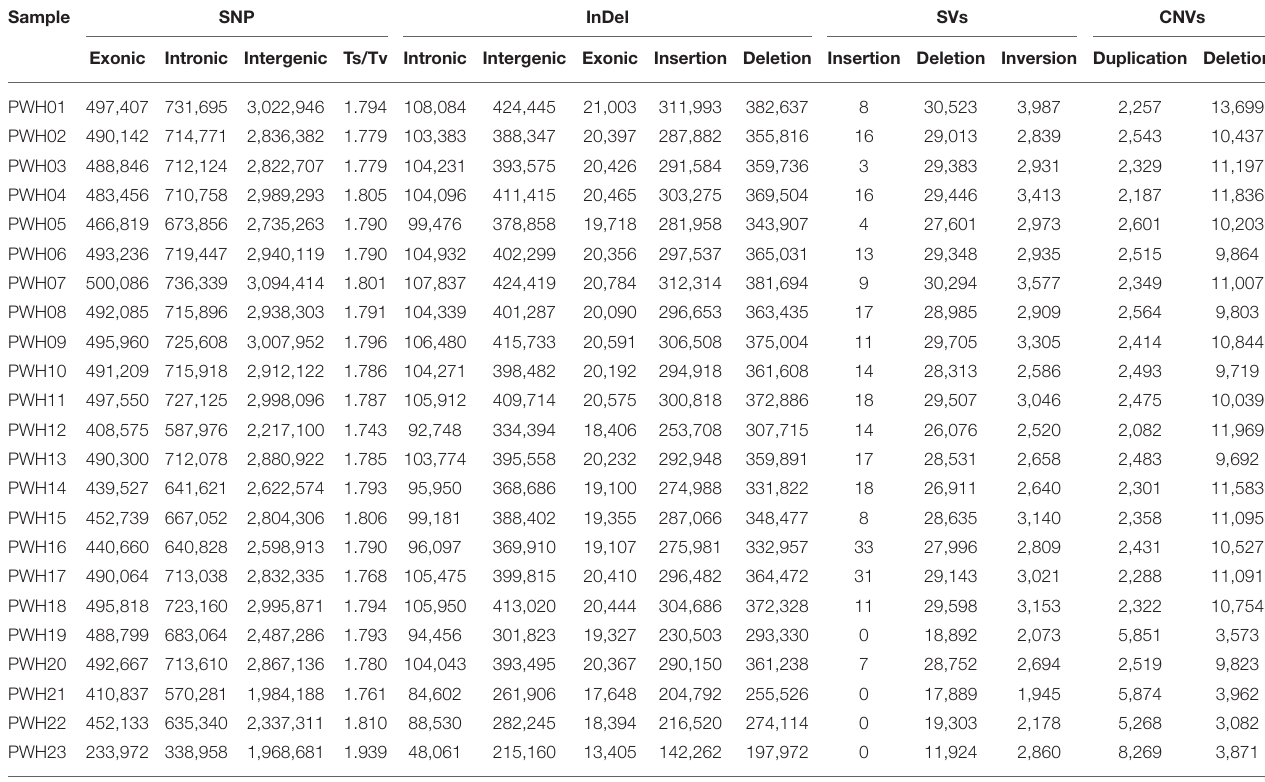
TABLE 1 | Genome-wide variations identified in 23 pyrus accessions. Sample SNP InDel SVs